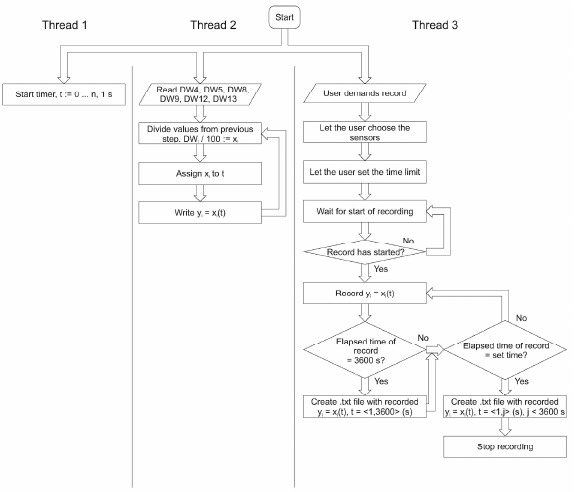
Figure 11. The desktop application algorithms.